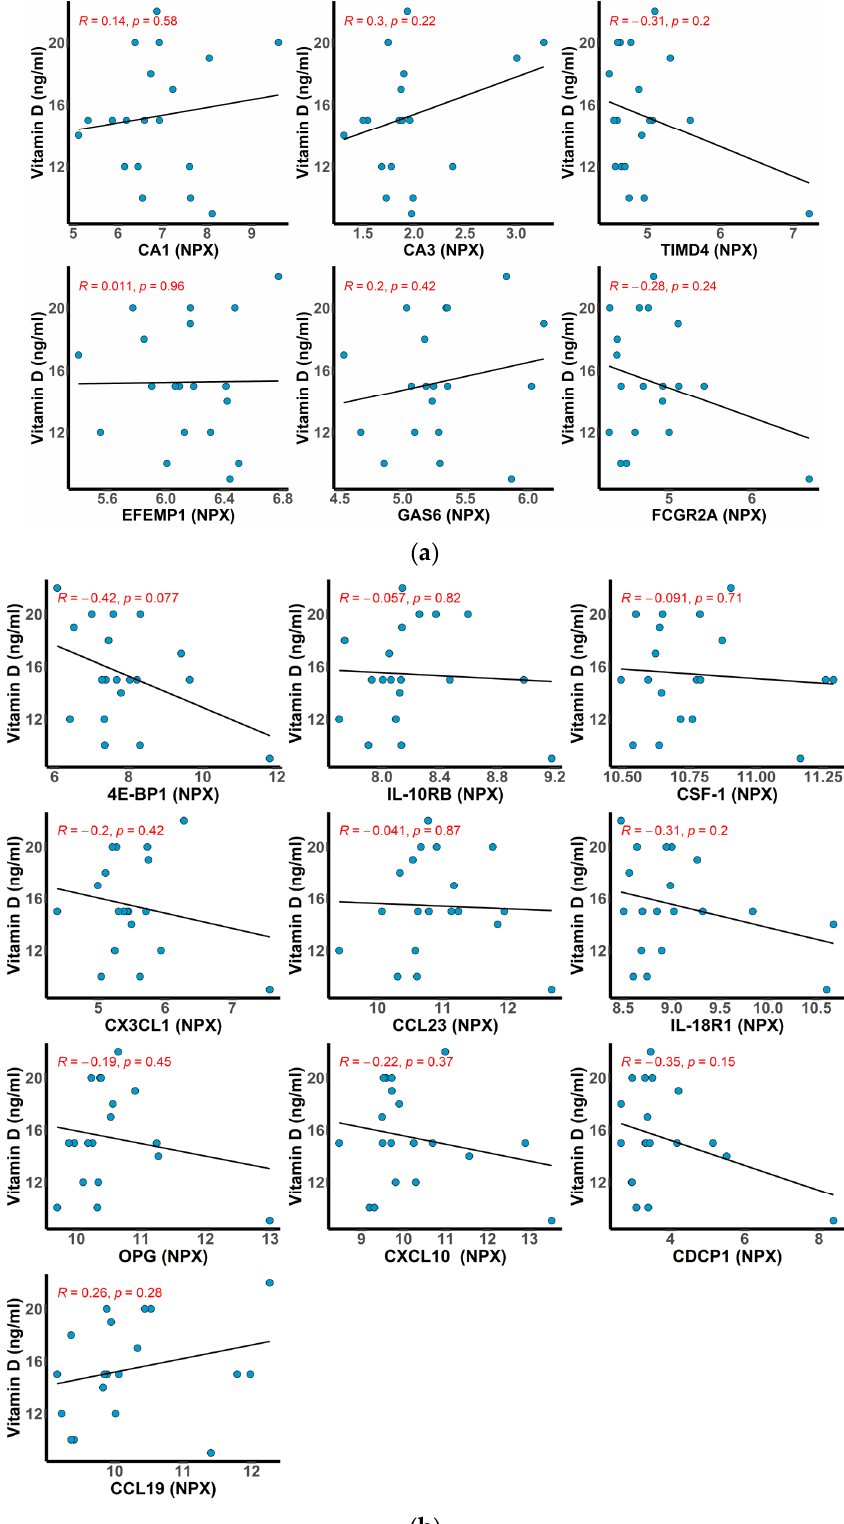
Figure 7. Scatter plots showing the correlation (Pearson) between the top differentially abundant proteins in AIH and the levels of serum vitamin D. The fitted linear regression line of each scatter plot is depicted along with the R and p values. ( a ) Cardiometabolic and ( b ) Inflammation.